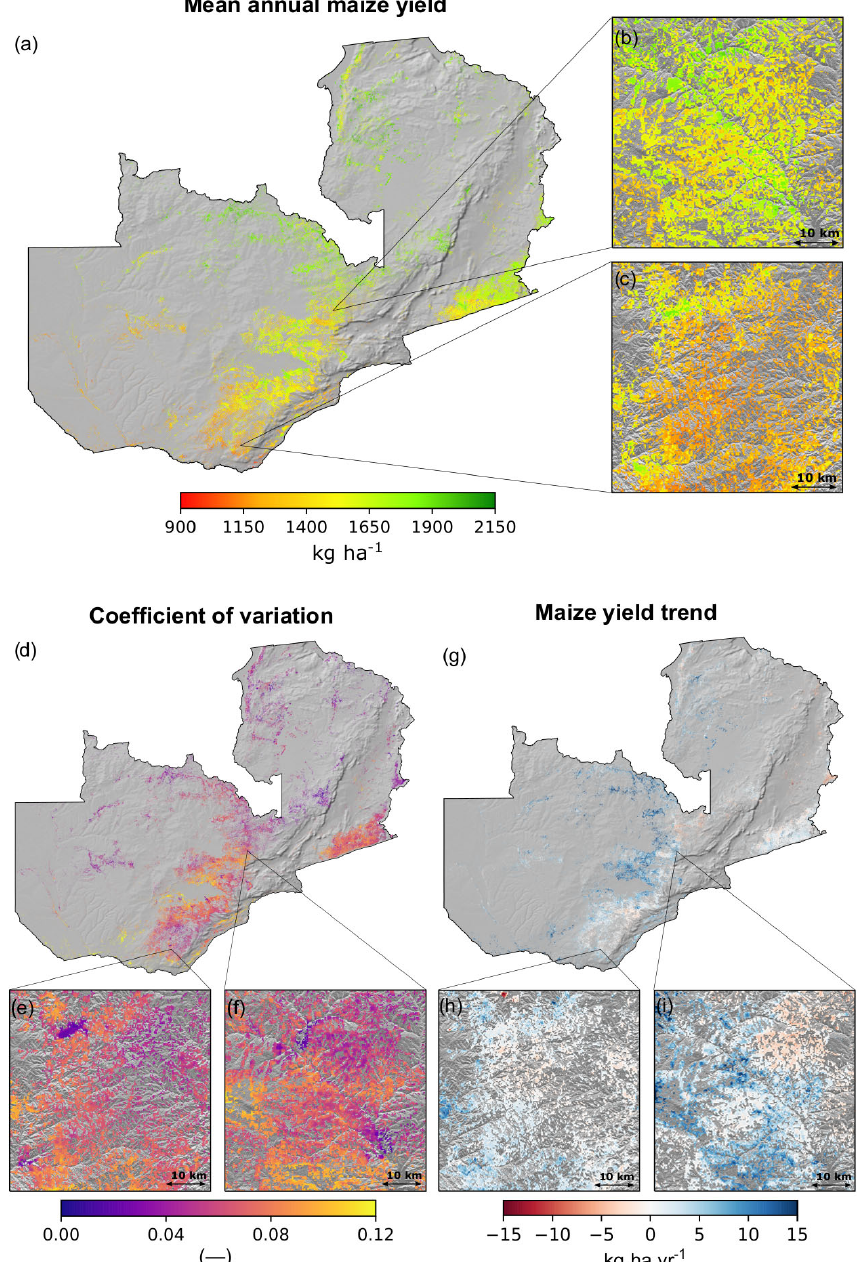
Figure 4. Annual maize yields (a) , coefficient of variation (d) , and maize yield trends (g) for the period between 2000–2018 estimated using a random forest model. Each magnified panel (b, c, e, f, h, i) shows the respective estimates at a 250m resolution for a 50km × 50km area.